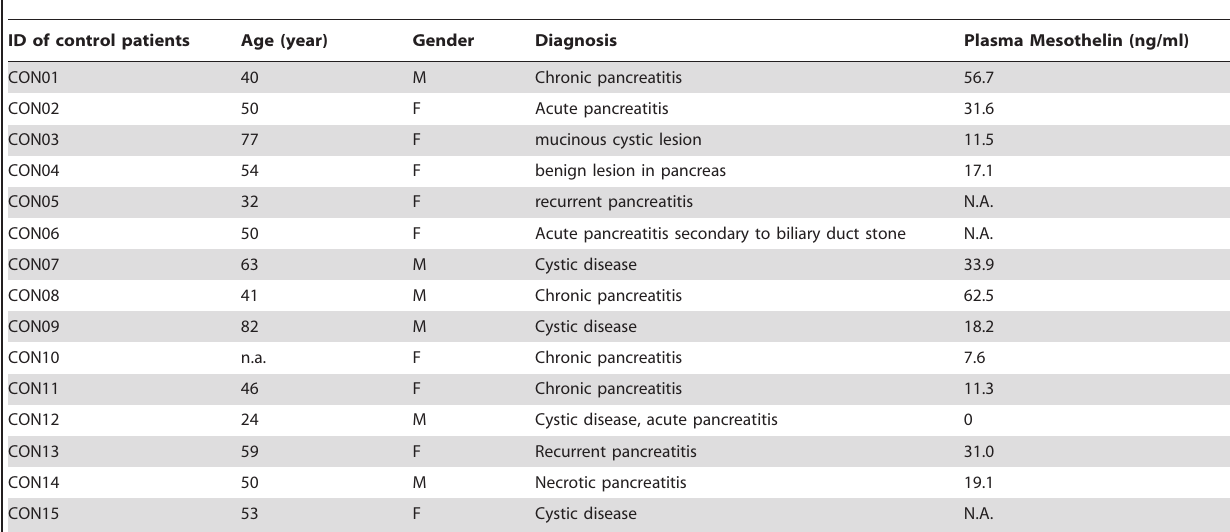
Table 2. Patients Demographic Information (Benign disease patients).